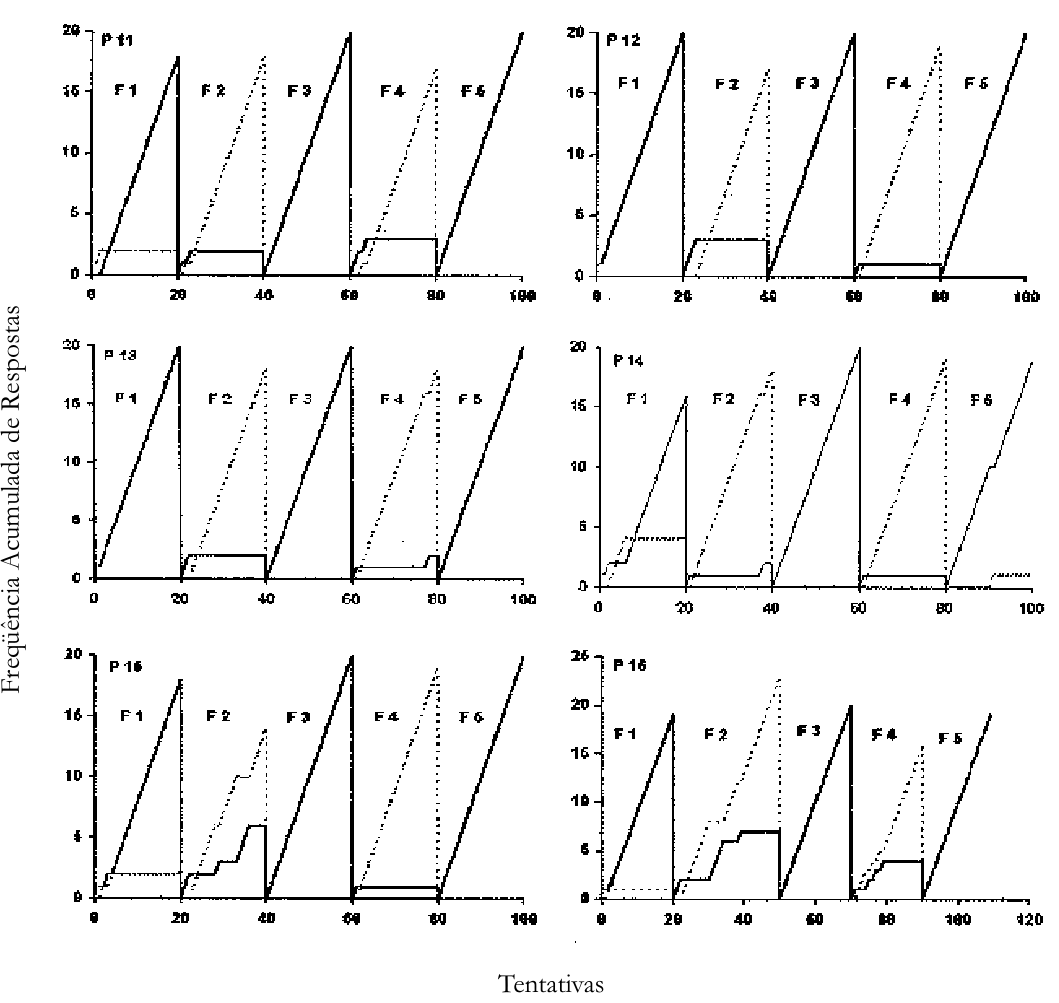
Figura 1. Freq(cid:252)Œncia acumulada de respostas de seguimento de instru(cid:231)ıes (linha s(cid:243)lida) e nªo seguimento de instru(cid:231)ıes (linha tracejada), para cada participante (P) da Condi(cid:231)ªo I, durante cada fase (F) experimental. Quebras na curva acumulada indicam mudan(cid:231)as de fase. As Fases 1, 2 e 3 eram iniciadas com instru(cid:231)ıes que correspondiam (cid:224)s contingŒncias. Nas Fases 2 e 4, as instru(cid:231)ıes tornavam-se discrepantes das contingŒncias. O observador estava presente na Fase 4. Psicologia: Reflexªo e Cr(cid:237)tica, 2004, 17(1),